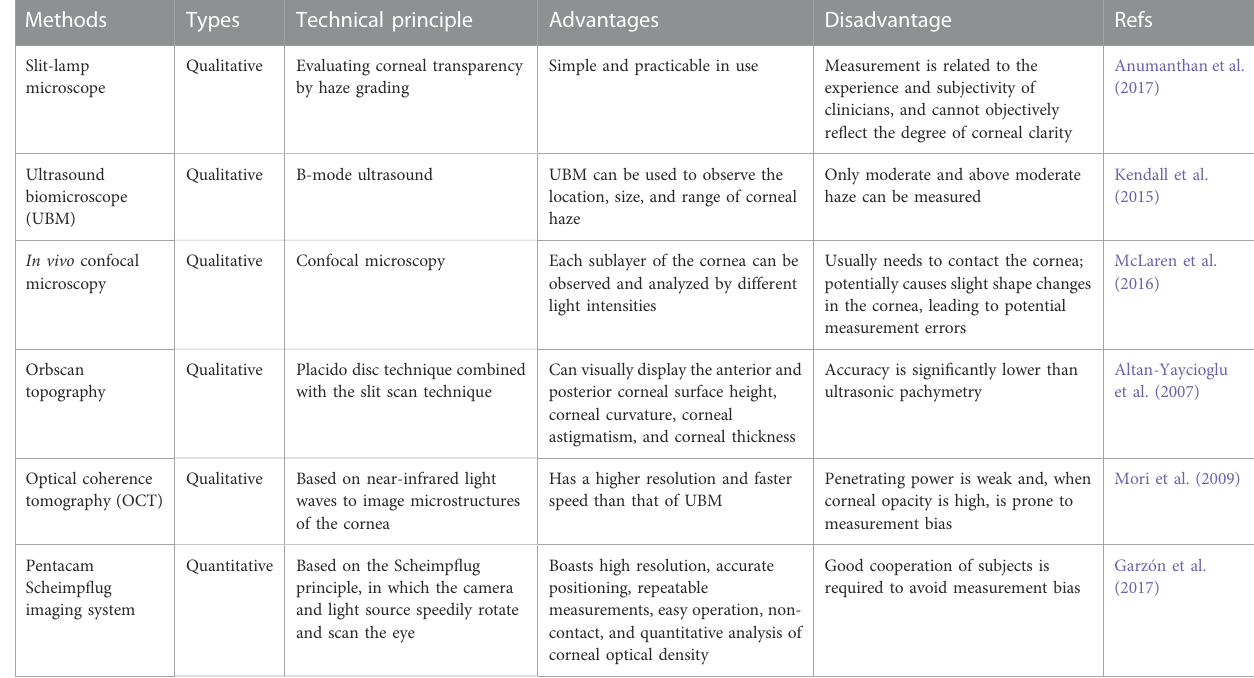
TABLE 1 Measurement methods of corneal optical